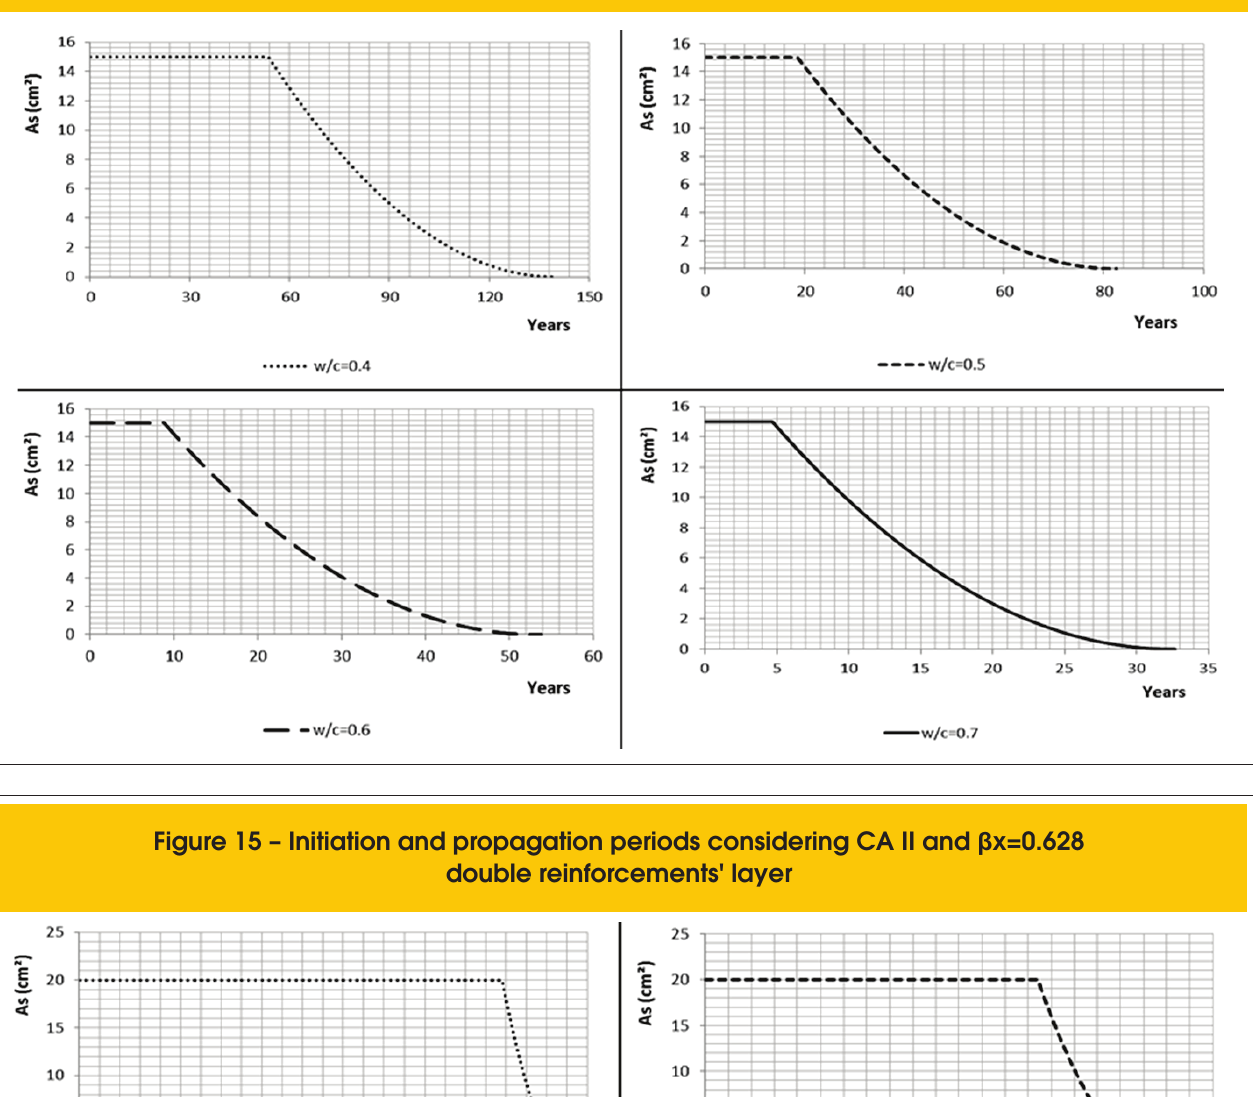
Figure 14 – Initiation and propagation periods considering CA III and β x=0.628